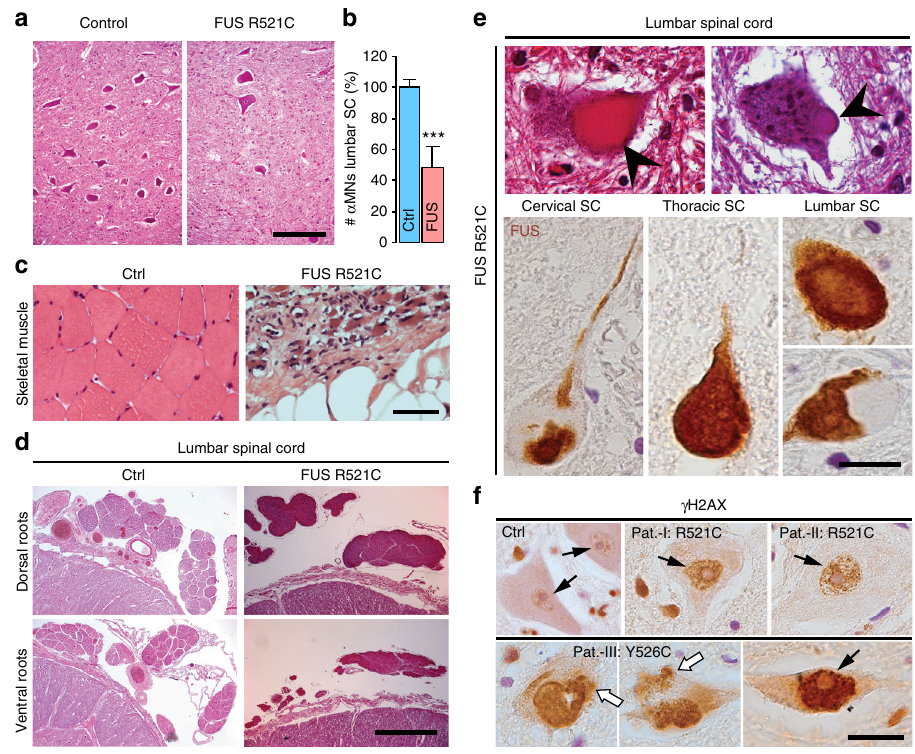
Fig. 3 Human FUS lumbar spinal cord and skeletal muscle histology. a Human FUS lumbar spinal cord histology: reduced α -MNs in the ventral horn, bar: 200 µ m. b Quanti fi cation of a from controls ( n = 5) compared to the FUSmts ( n = 4) cases. Quanti fi cation done on H&E staining; 5 consecutive paraf fi n sections per case. Data are plotted as mean, error bars = STDEV, unpaired t -test (*, **, *** P values of 0.05, 0.01, and 0.001, respectively). c Severe atrophy of skeletal muscles and replacement of skeletal muscle parenchyma by connective and fat tissue in FUSmts, bar: 200 µ m. d Ventral versus dorsal roots atrophy, bar: 900 µ m. e FUS aggregates in lumbar spinal cord α -MNs (arrow in upper panel), HE staining, bar: 40 µ m ; lower panel, FUS-inclusions in α - MNs (different spinal cord levels: cervical, thoracic, lumbar), bar: 30 µ m. f Representative IHC of human ALS-FUS cases with DSB marker γ H2AX antibody (black arrows), of lumbar spinal cord α -MNs. Note the peculiar cytoplasmic staining of γ H2AX in one particular case (white arrows). Paraf fi n section, bar: 50 µ